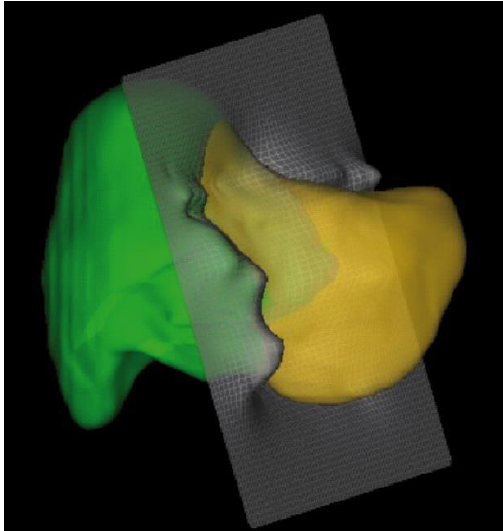
Figure 6. 3D picture of the liver before surgery measured by CT volumetry. LiMAx value before surgery was 639 µg/kg/h. Liver segment 2 and 3 (yellow) are identified to remain after surgery with a calculated remnant volume of 31%.